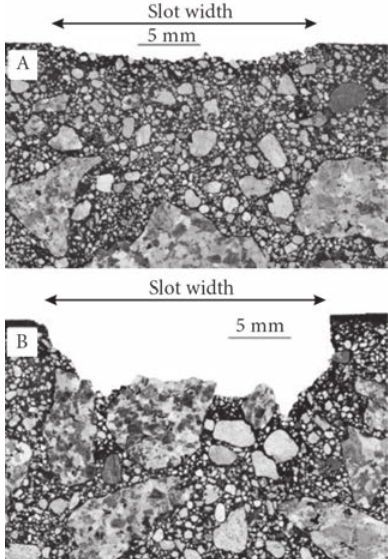
Fig. 7. Cross-section of slots created by flat continuous jet (A) and flat pulsating jet (B) in C45/55